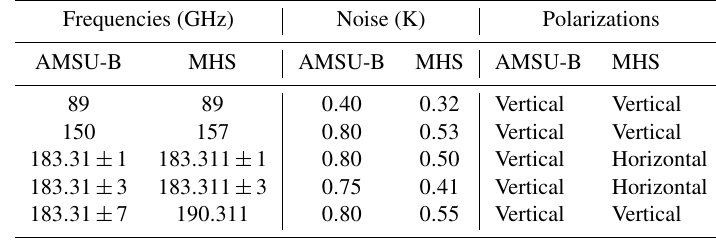
Table 1. AMSU-B and MHS instrument specifications including frequencies, noise equivalent differential temperature, and nadir polariza- tion orientations (Kleepsies and Watts, 2006). Entries like 183 . 31 ± 1GHz imply that two frequency bands at 182 . 31 and 184 . 31GHz are combined. Vertical and horizontal polarization refers to cross-track and along-track polarization respectively. Frequencies (GHz) Noise (K) Polarizations AMSU-B MHS AMSU-B MHS AMSU-B MHS 89 89 0 . 40 0 . 32 Vertical Vertical 150 157 0 . 80 0 . 53 Vertical Vertical 183 . 31 ± 1 183 . 311 ± 1 0 . 80 0 . 50 Vertical Horizontal 183 . 31 ± 3 183 . 311 ± 3 0 . 75 0 . 41 Vertical Horizontal 183 . 31 ± 7 190 . 311 0 . 80 0 . 55 Vertical